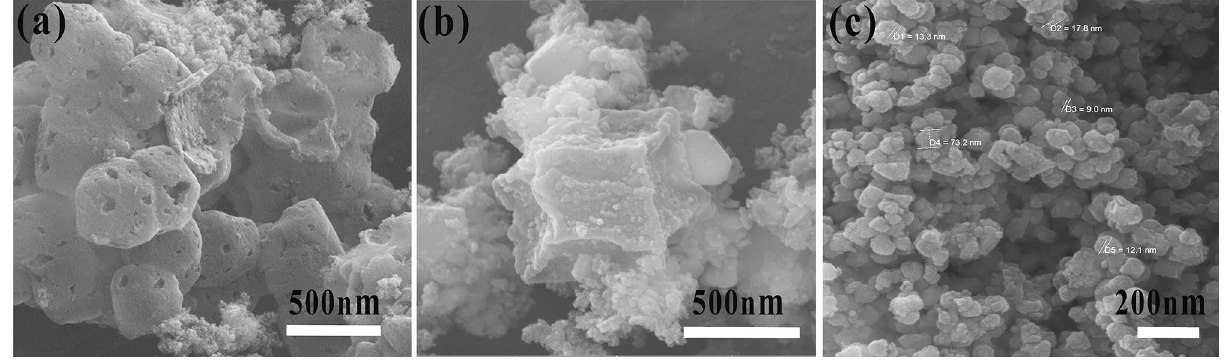
Figure 3. SEM images of ( a ) H-CoNiSe 2 /NC, ( b ) CoNiSe 2 /NC, and ( c ) NiSe 2